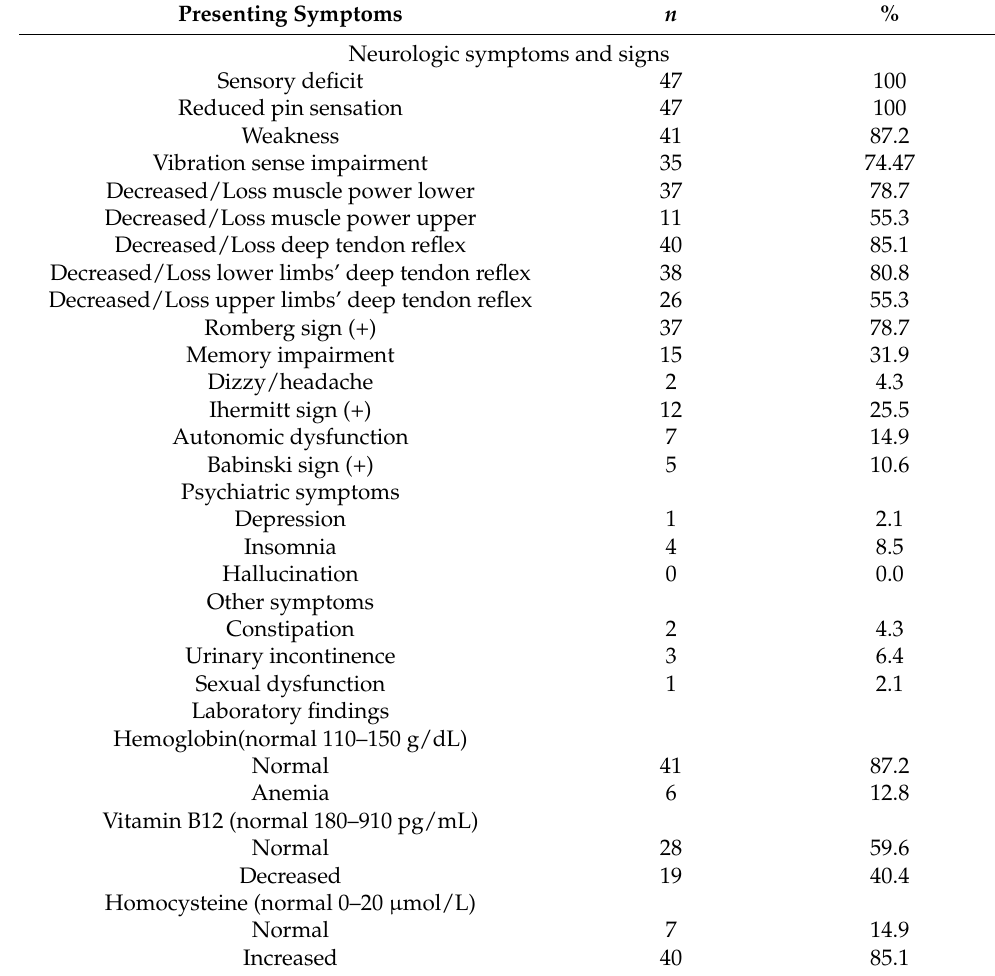
Table 2. Clinical characteristics and laboratory findings ( n =